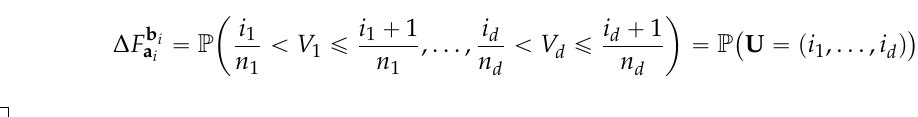
1) and flooding ( i 2) losses “ “